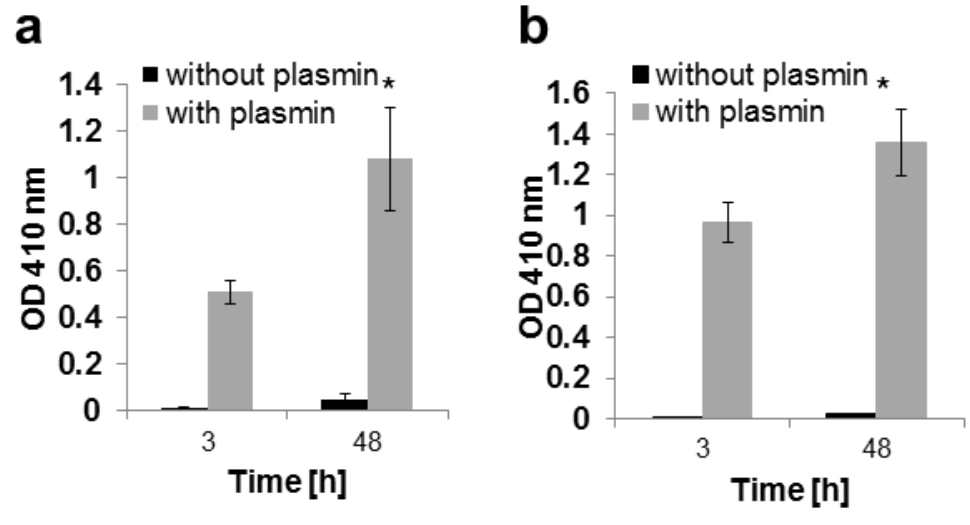
Figure 4. Growth factors are released and active after incorporation into fibrin gels and digested by plasmin as measured with an alkaline phosphatase assay and assessed at 410 nm. The activity for the plasmin-digested growth factor is significantly higher at 48 h than 3 h, * p < 0.05 ( a ) TG-BMP-2; ( b ) TG-BMP-2/BMP-7.